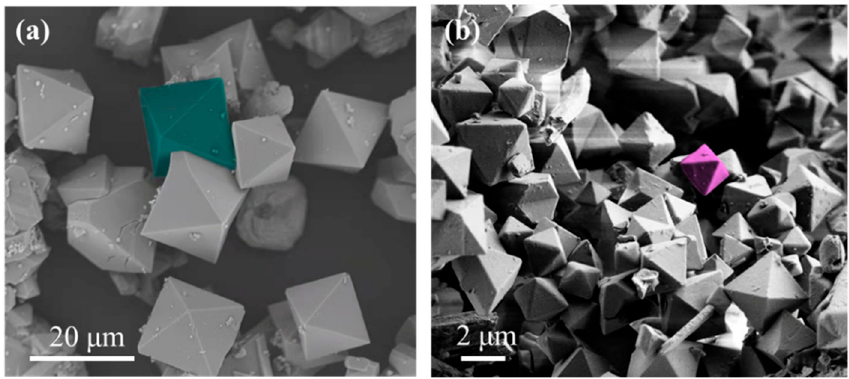
Figure 2. SEM images of pristine Cu-BTC ( a ) and PV-Cu-BTC ( b ). To further investigate the influence of PVP on the molecular structure of Cu-BTC, the FT-IR spectra of PV-Cu-BTC and pristine Cu-BTC were recorded, as shown in Figure 3. The detected peak at 3419 cm − 1 could be assigned to the hydroxyl (H-O) stretching vibration in carboxyl (-COOH), which is the functional organic linker to construct the sketch of Cu-BTC. The characteristic peaks belonging to the asymmetric and symmetric stretching vibration peaks of carboxyl were also observed at 1641 and 1444 cm − 1 , respectively. In addition, the peak at 1373 cm − 1 was assigned to the C-O bond stretching vibration while the peak at 730 cm − 1 was the fingerprint band of the C-H in benzene rings. Comparing with the FT-IR spectrum of pristine Cu-BTC, little difference could be found in the case of PV-Cu-BTC, suggesting almost no chemical structural changes of Cu-BTC with PVP mod- ulation.